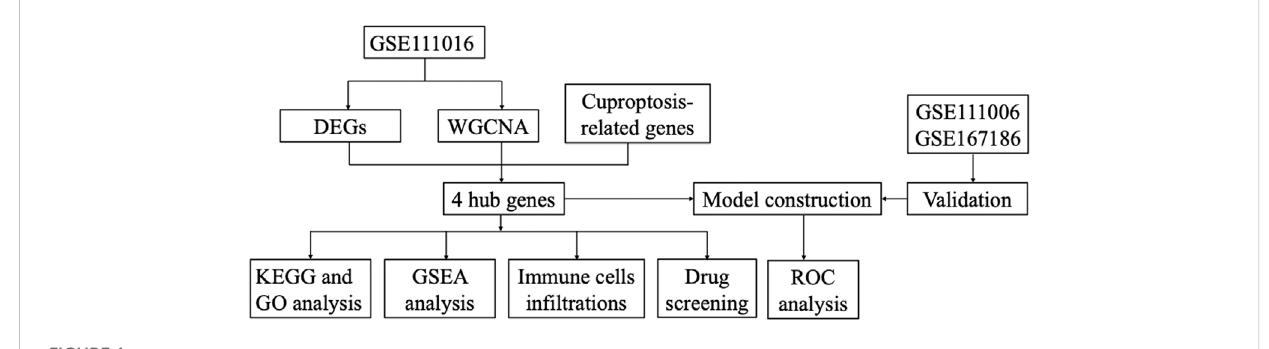
FIGURE 1 The fl owchart of the study.